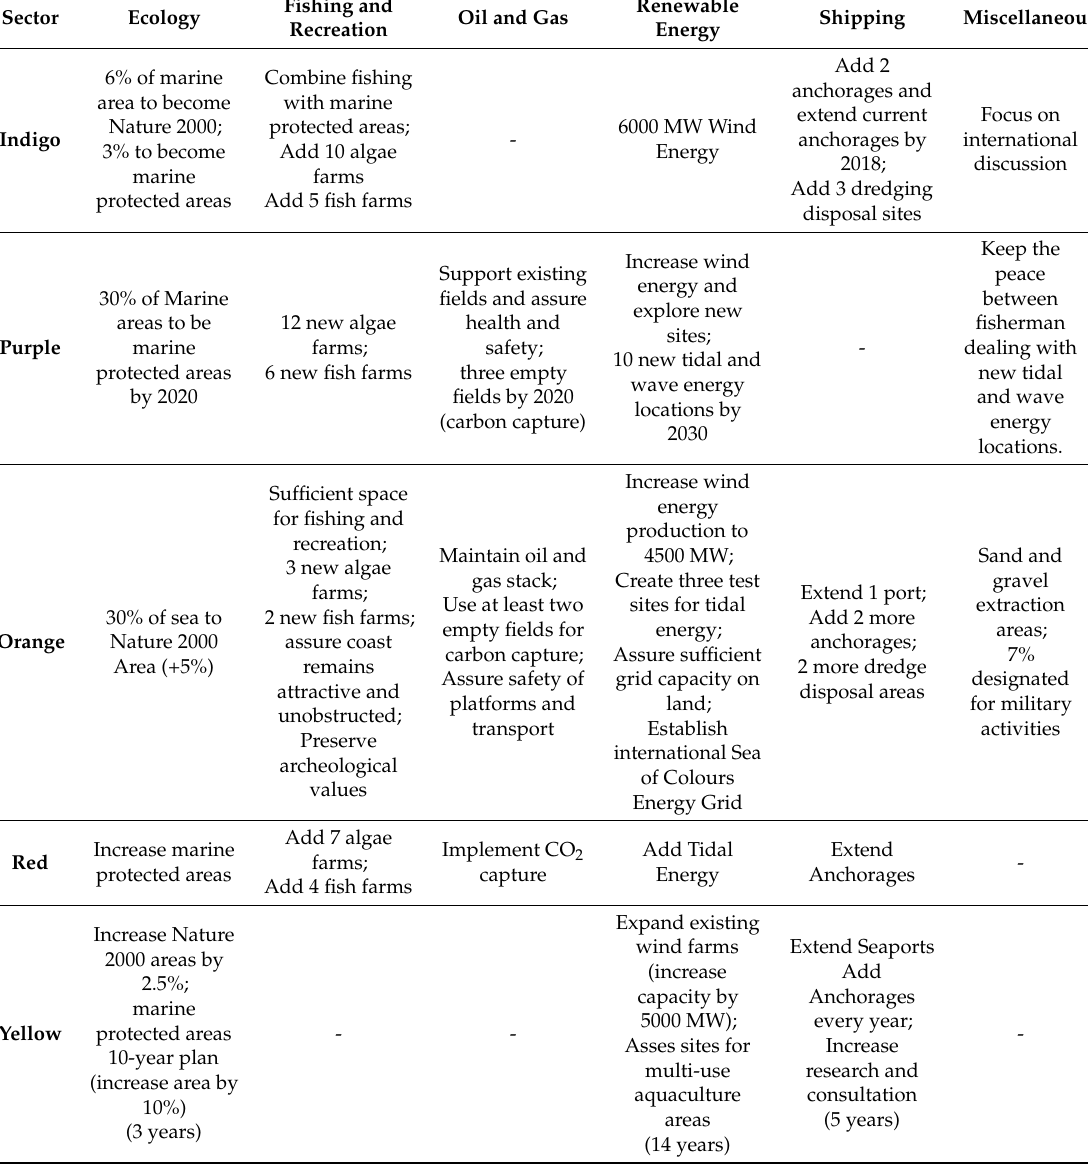
Table 8. Results of the planning phase.